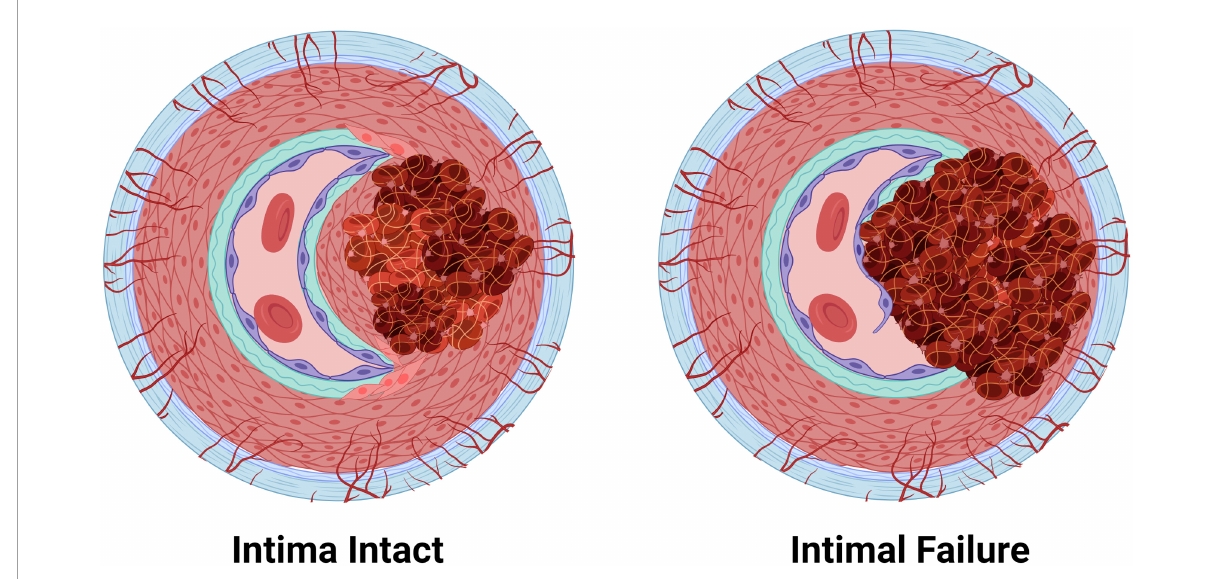
FIGURE4 The two pathologies of arterial dissections: bleeding within the tunica media results in intramural hematoma formation with separation of the tunica media layer to create a false lumen that causes occlusion of the true lumen of the vessel, thereby preventing tissue perfusion. Some dissection events are associated with tunica intima tearing (intimal failure). Created with